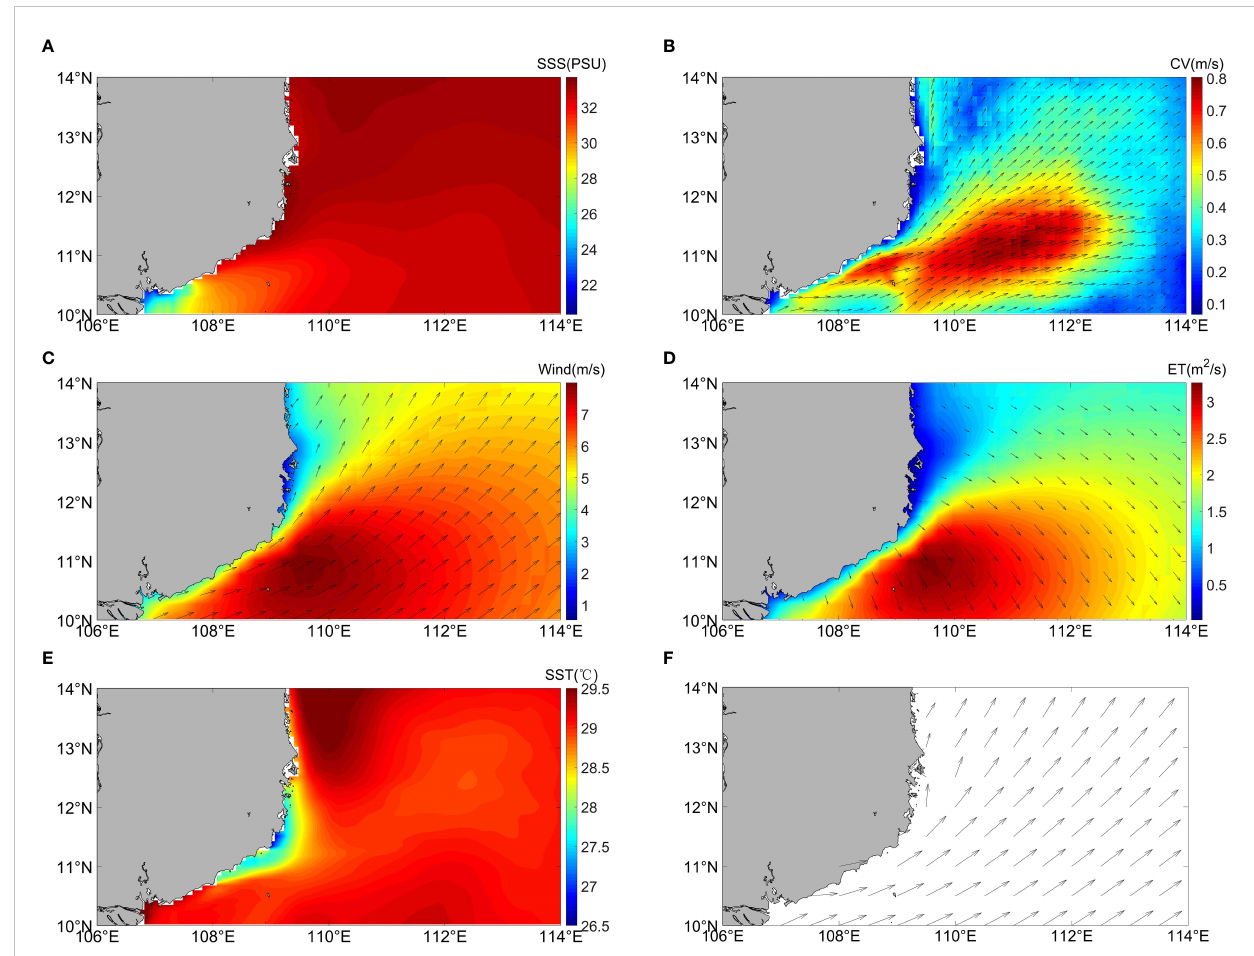
FIGURE 8 Spatial distribution of (A) SSS; (B) Cu; (C) WD; (D) ET; (E) SST; (F) MDWW. (July to September).